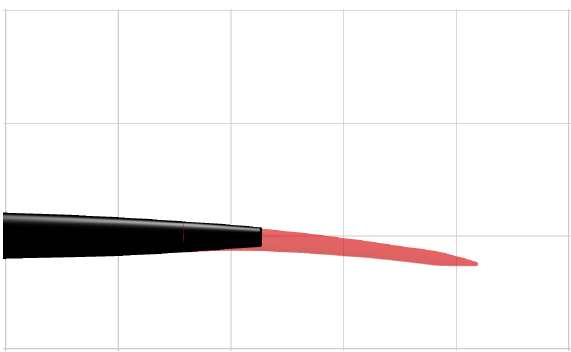
Figure 1. Example tip shape applied on a wind turbine blade (Bar- las et al., 2020).